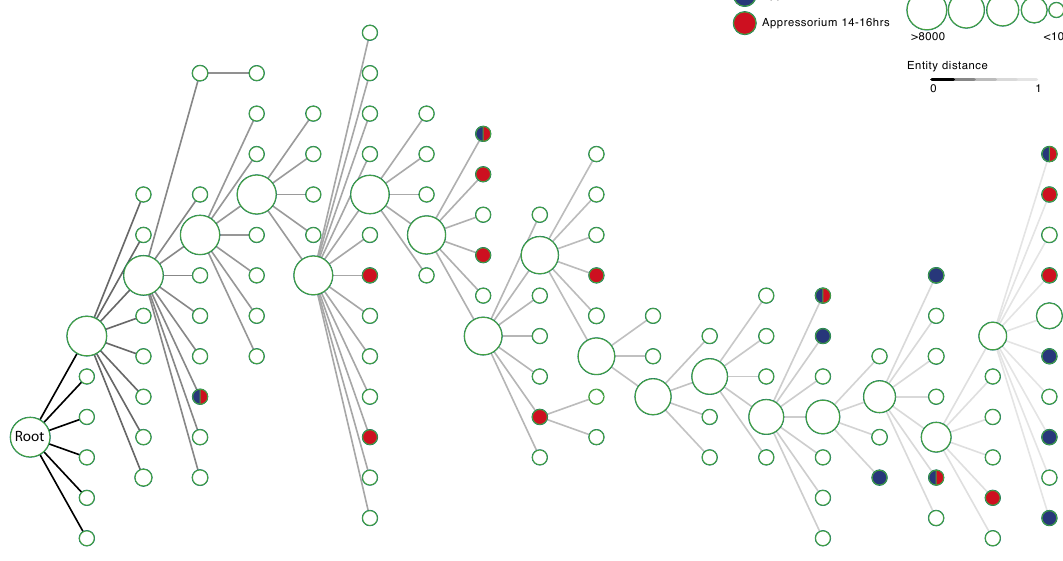
Figure 2. The structure of a M. oryzae network-extracted ontology. Nodes represent entities that contain groups of genes and edges represent relationships between entities. Entities are sized by the number of genes they contain and edges are shaded to show a measure of distance between entities. Entities coloured in blue and red depict clusters of genes that are enriched for up-regulated genes at 4–8 h and 14–16 h timepoints during appressorium development respectively. Entities that contain five or more genes are included in the visualisation. The root node that contains the whole system is